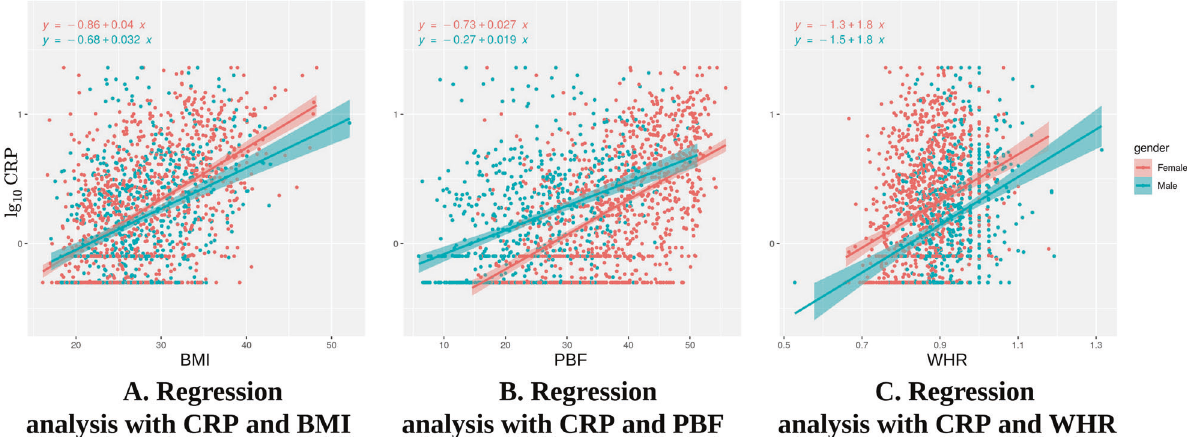
Fig. 3 Linear regression plots for C-reactive Protein (CRP) versus Body Mass Index (BMI), Percent Body Fat (PBF), and Waist-to-Hip Ratio (WHR). The plots show the effect of the potential confounding variable [sex — female (pink); male (green)] on the regression analysis of the relationship between CRP and obesity indices (BMI, PBF, and WHR). A The regression plot shows that when controlling for BMI, CRP is higher in females compared to males. B The regression plot shows that when we control for PBF, CRP is higher in males compared to females. C The regression plot shows that when we control for WHR, CRP is higher in females compared to males.